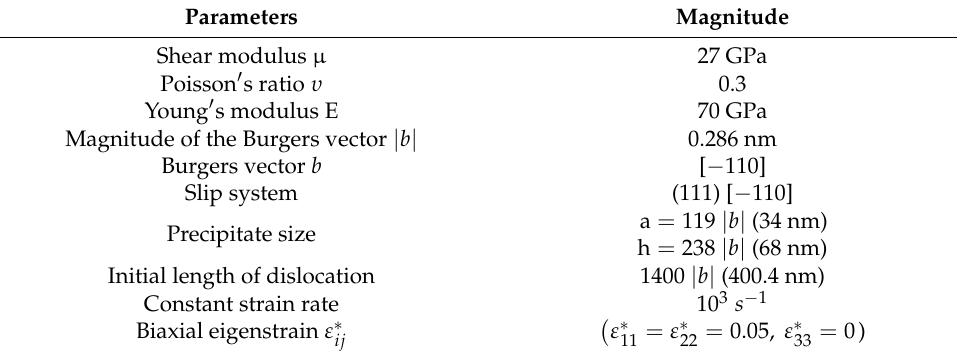
Figure 2. The geometry of dislocation interaction with a [001] rod precipitate. ( a ) <001> rod and edge dislocation in x-y-z global (dislocation) coordinate. ( b ) Discretized [001] rod precipitate in x 1 -x 2 -x 3 local (precipitate) coordinates. Table 1. Parameters of the simulation